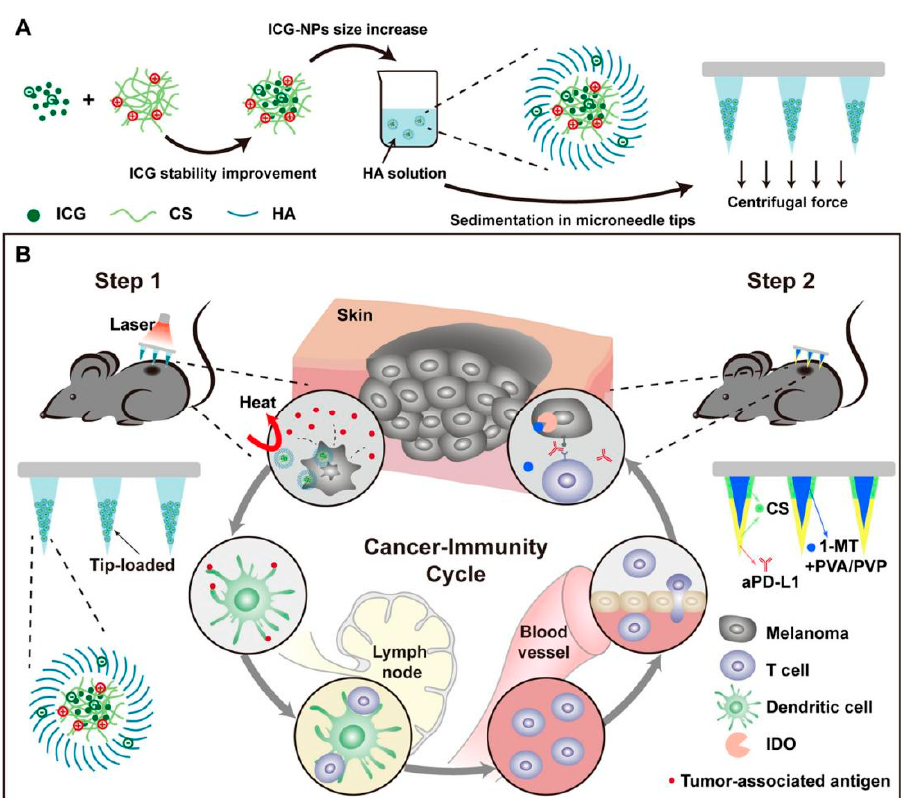
Figure 11. Schematic diagram of indocyanine green-nanoparticle microneedles (ICG-NP MN): preparation and treatment of melanoma cancer. (Images were reproduced with permission from [76]).